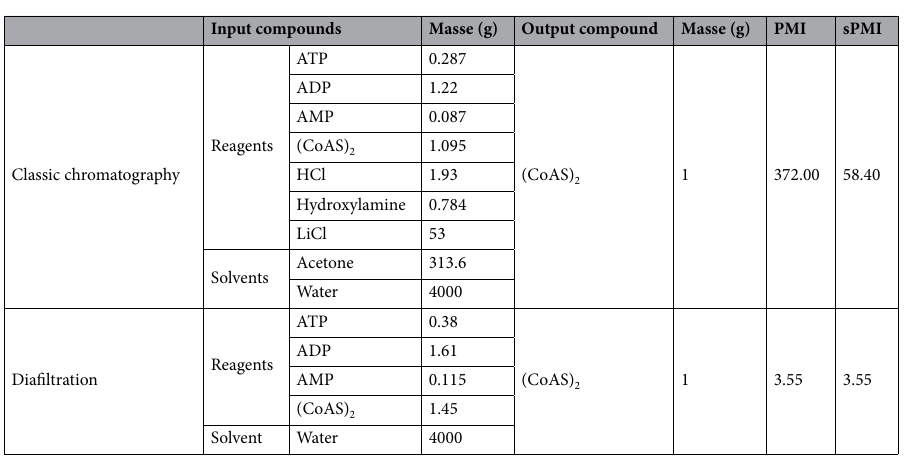
Table 3. The calculations of the PMI and sPMI of classic chromatography and